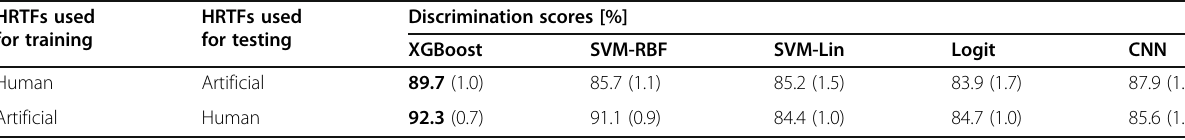
maximum mean accuracy